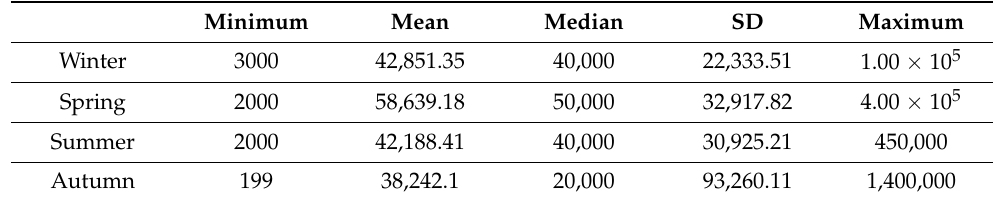
Table 4. Continuous factors associated with the crop damage ( n = 694) by wild boars used in the crop damage-based PCA. The values shown include the means, medians, standard deviations, minimums, and maximums of the factors used in the crop damage-based